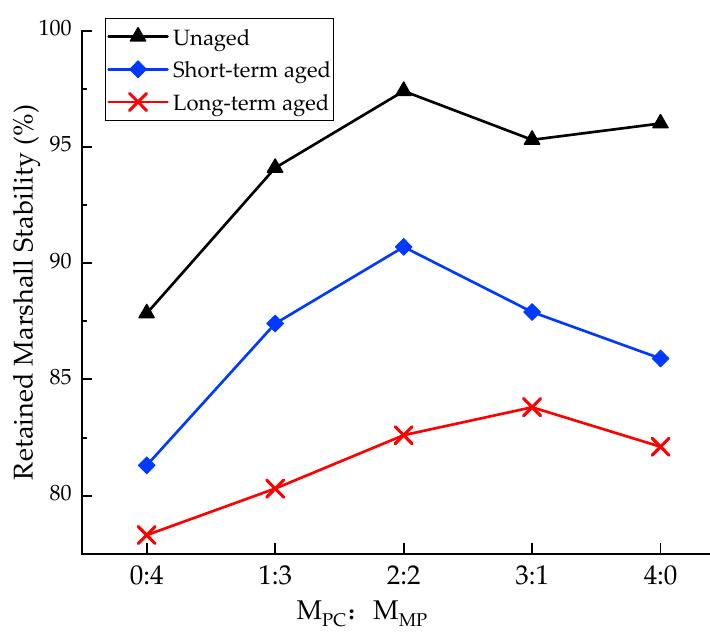
Figure 4. Residual stability for three aging degrees.